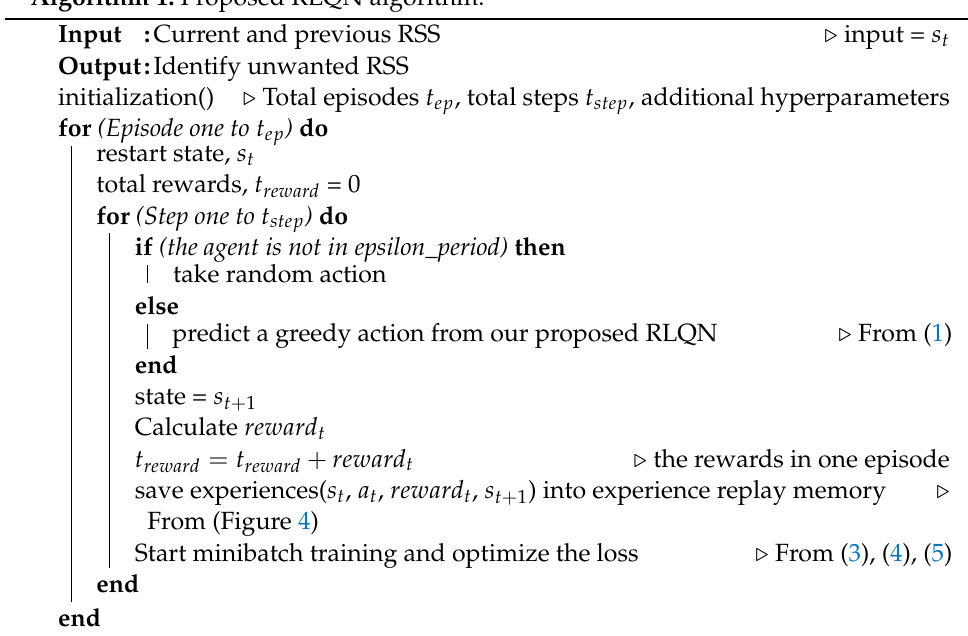
Algorithm 1: Proposed RLQN